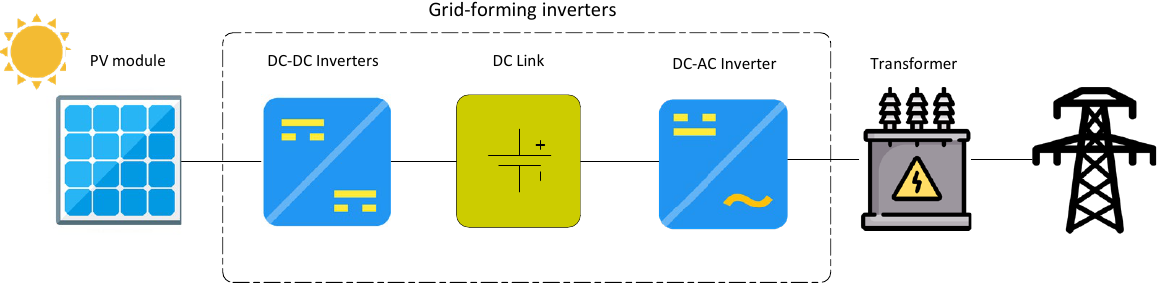
Figure 4. Schematic of grid-forming inverters. The above diagram, for a grid-forming inverter, can be extended to develop a grid-forming VPP. A schematic is illustrated in Figure 5. As can be seen from this procedure, houses are equipped with solar panels. The generation of these panels is connected to the VPP control center by means of a grid-forming inverter. Inverters convert the DC power generated by the PV sources into AC form. The AC power is used to supply consumers, and extra power is sold to the main grid. It should be noted that the GFM inverter can also absorb/inject reactive power into the network.